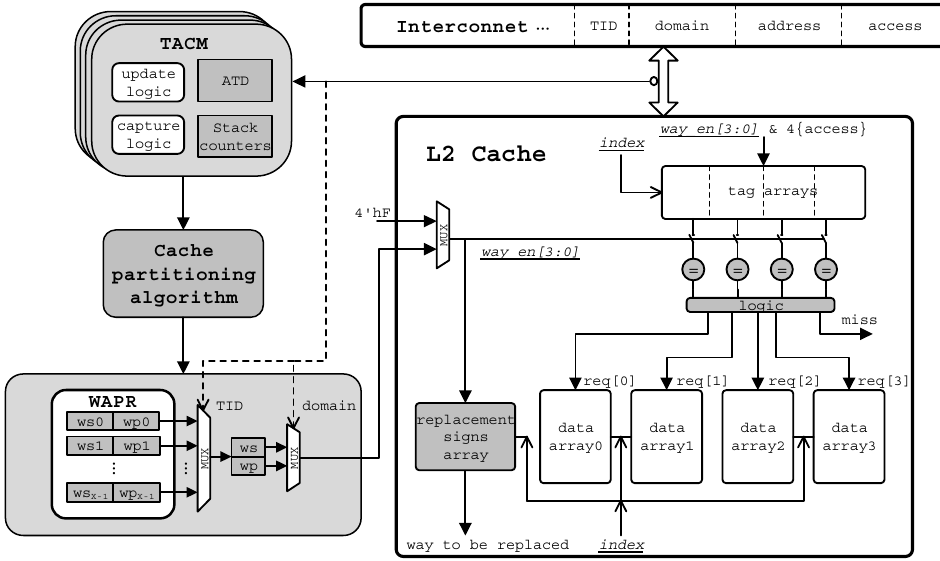
Figure 8. ATCP scheme for multicore processor.